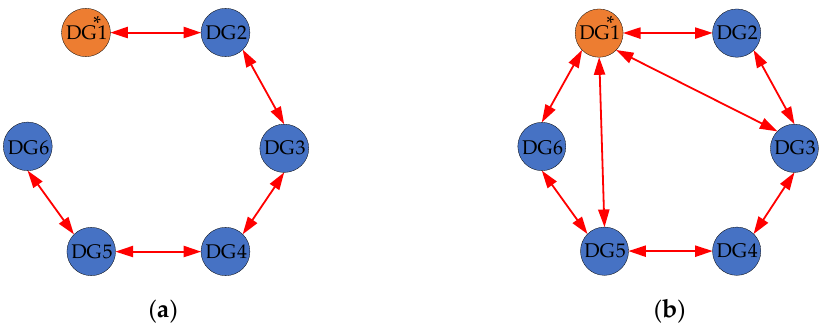
Figure 20. Communication topologies of low algebraic connectivity and high algebraic connectivity: ( a ) communication topology of low algebraic connectivity; ( b ) communication topology of high algebraic connectivity.